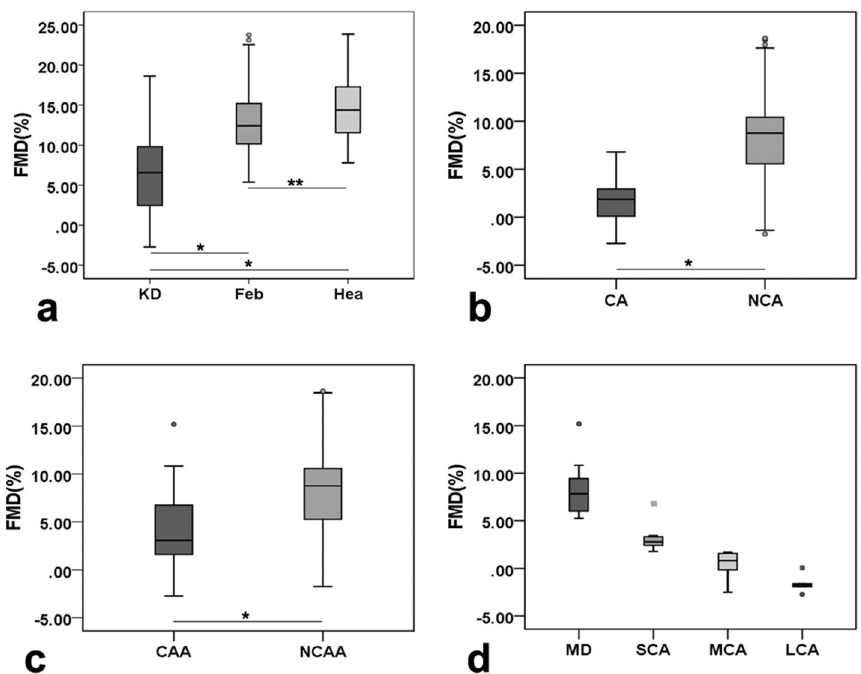
Figure 3. Comparison and distribution of flow-mediated dilation (FMD) among groups. KD Kawasaki disease; Feb febrile (controls); Hea healthy (controls); CAA coronary artery abnormality; NCAA no coronary artery abnormality; CA coronary aneurysm; NCA no coronary aneurysm; MD mild dilation; SCA small coronary aneurysm; MCA middle coronary aneurysm; LCA large coronary aneurysm. Box plots showing ( a ) comparison of FMD among the KD, febrile and healthy groups; ( b ) comparison of FMD between the CAA and NCAA groups; ( c ) comparison of FMD between the CA and NCA groups; ( d ) distribution of FMD among the subgroups of CAA group. (* P < 0.01; ** P > 0.05). Circles denote outlier cases, and squares denote extreme